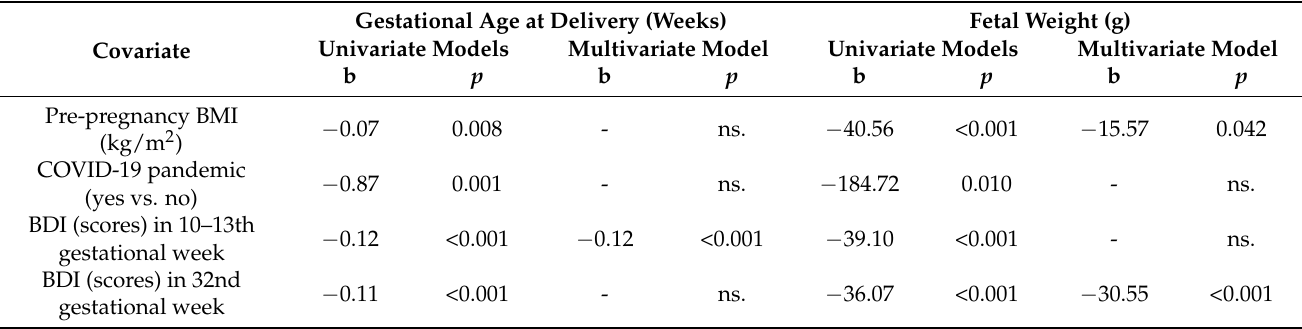
Table 3. Univariate and multivariate regression models of gestational age at delivery or fetal weight against pre-pregnancy BMI, COVID-19 pandemic, and severity of depression.